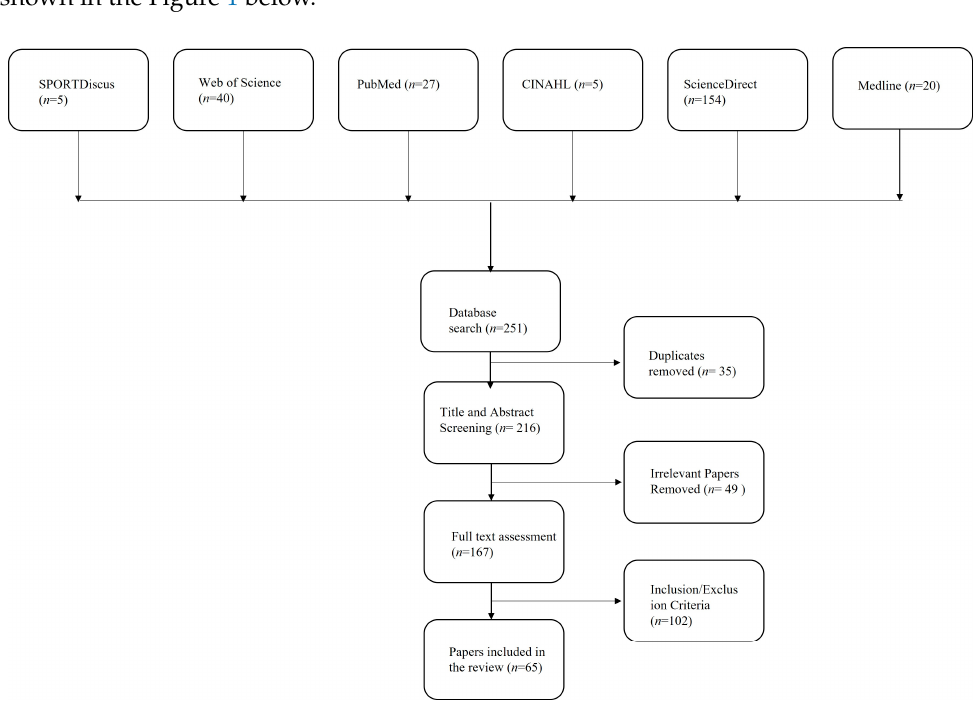
Figure 1. Bibliographic research flow diagram.